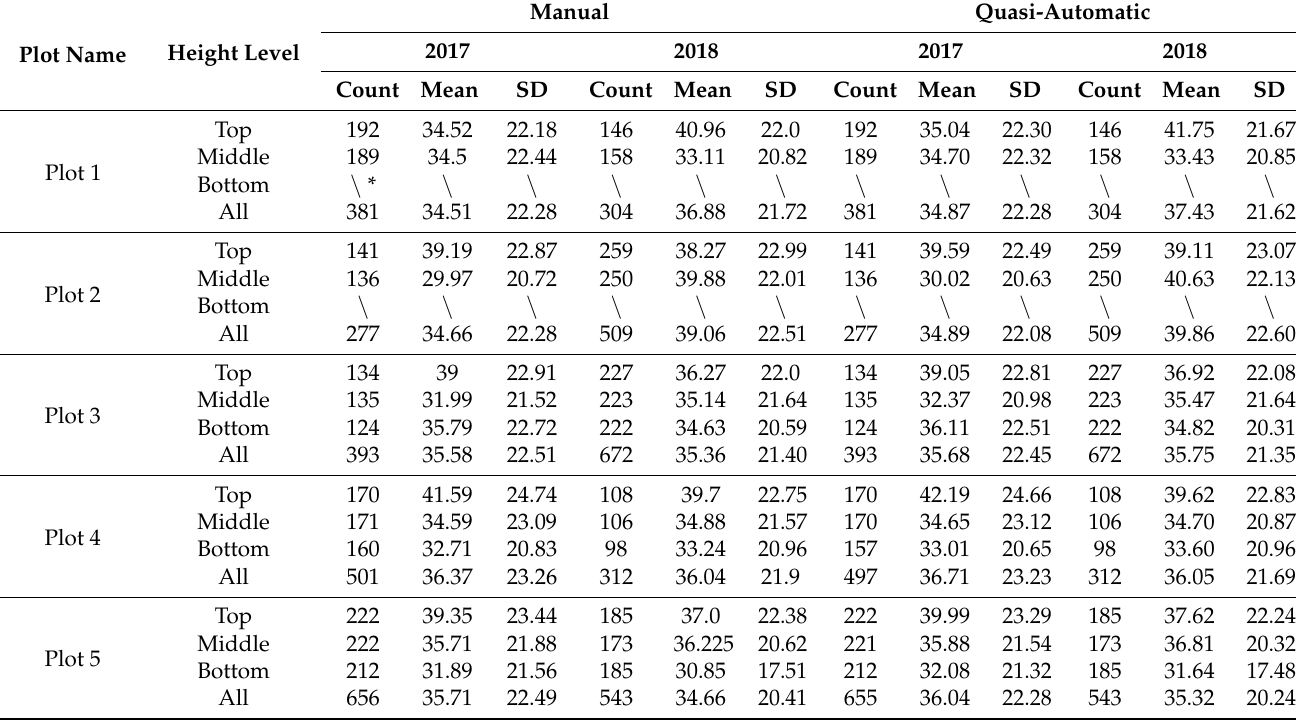
Table 2. Statistical characteristics (i.e., number of measurements (count), mean needle inclination angle (mean), and standard deviation (SD)) of the needle inclination angle distribution function (NIDF) measurements, which were derived using the manual and quasi-automatic estimation methods, respectively, in the five plots. The quasi-automatic method failed for ten needle samples, the results of which were not included for the quasi-automatic method measurements.